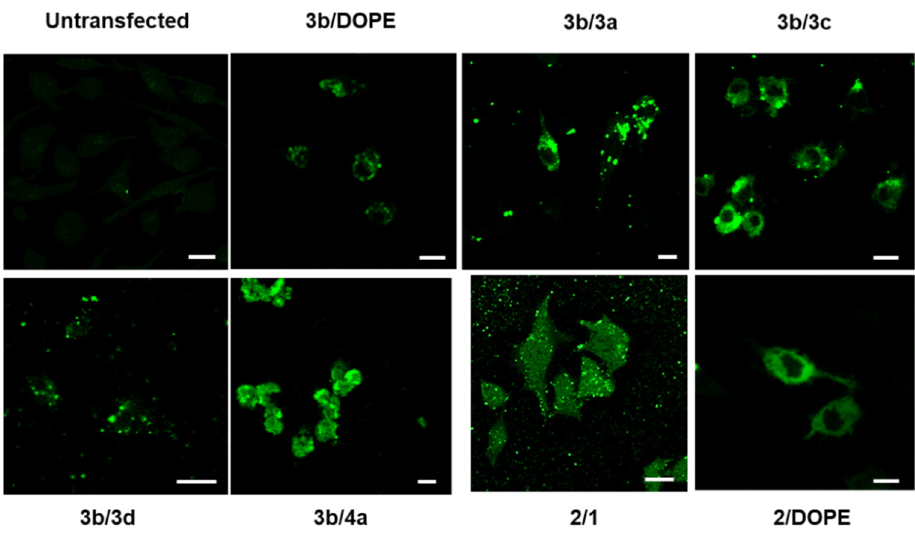
Figure 4. Confocal microscopy analysis of upon transfection mRNA-LX. DC2.4 cells were transfected for 2 h with 2.5 µ g of fluorescein labelled IVT mRNA complexed with the indicated liposomes at mRNA/L 1/0.5. In 3b / DOPE and 2 / DOPE LX, the lipid molar ratio was 2/1. Scale bars = 25 µ